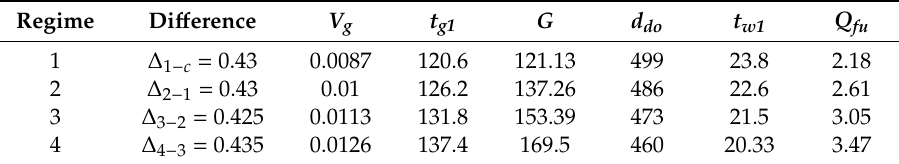
Table 3. Regimes to determine